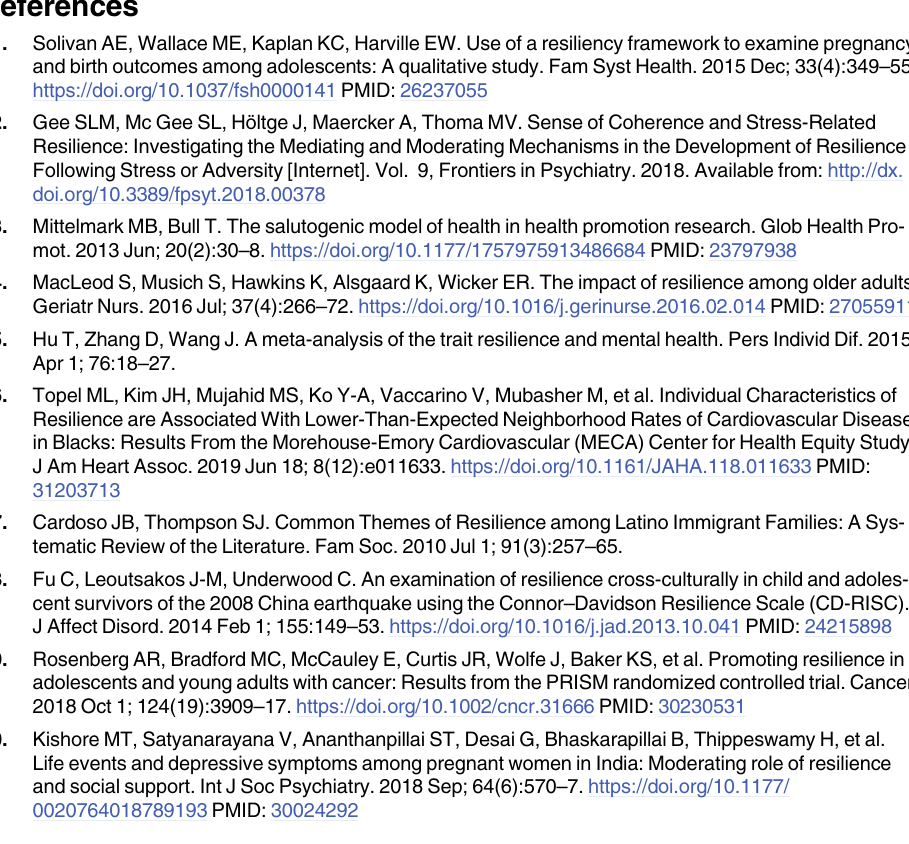
S1 Fig. Distribution of Add Health Resilience Instrument scores. S2 Fig. Evidence of the AHRI’s construct validity using CESD-10